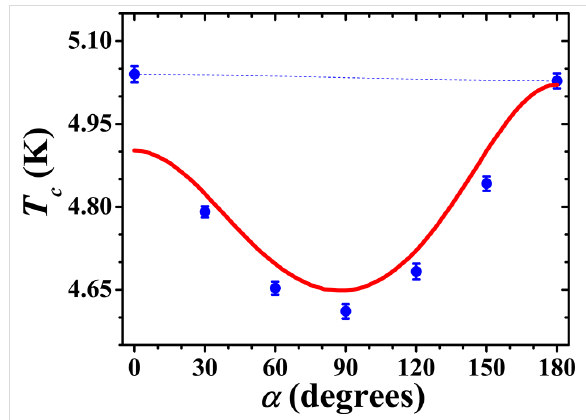
Figure 3: Dependence of T c on the angle α between the direction of the cooling field used to fix the direction of the magnetization of the Ni layer and the applied magnetic field H 0 =2 kOe, which rotates the mag- netization of the HA layer for sample PLAK4216 HA(20 nm)/Cu(4 nm)/ Ni(2.5 nm)/Cu(1.5 nm)/Pb(105 nm). The solid line is the theoretical curve with the parameters presented in section “Discussion”.